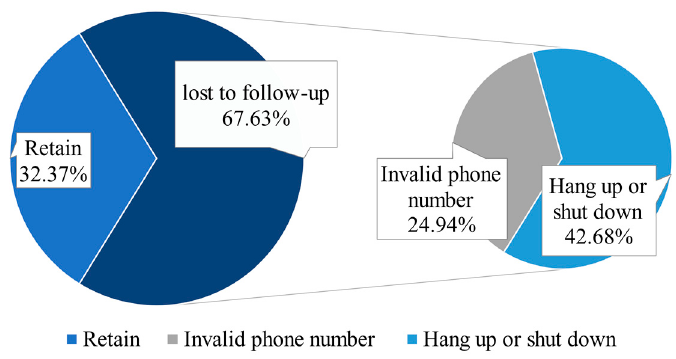
Figure 2. Telephone follow-up results of HSCD volunteers.